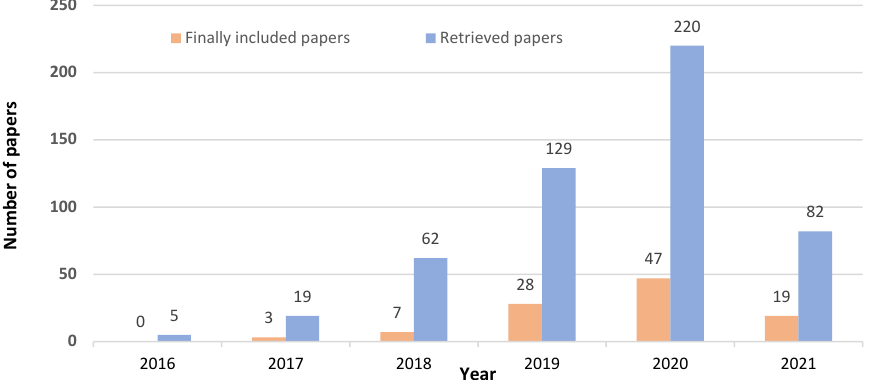
Figure 2. Yearly distribution of papers retrieved (blue) and finally included (orange) in our scop- ing review.